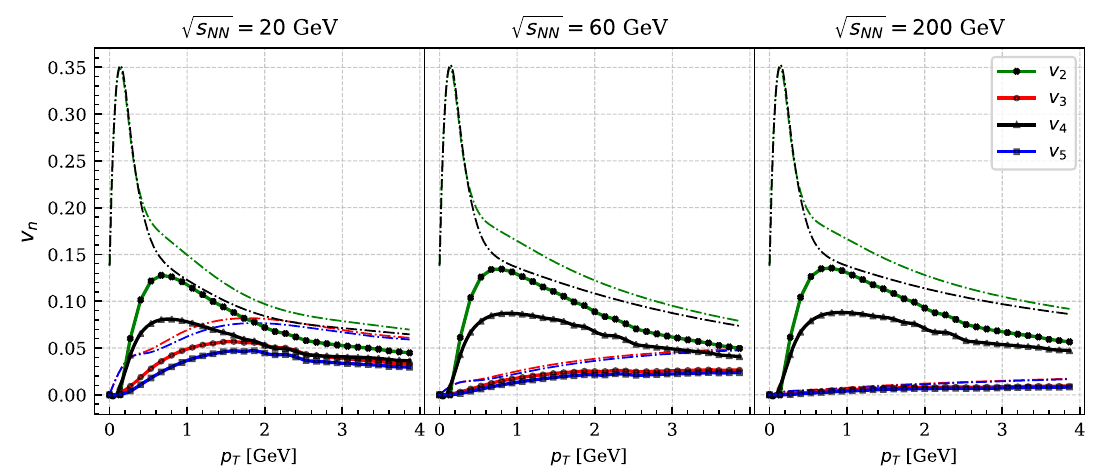
Fig. 4 Azimuthal harmonics computed using the prescription of Eq. (19). The parameters used for this plot are μ T = μ g = 0 . 4 GeV, μ = 0 . 2 GeV and η = η = 1 . 5. The dashed lines are the result P 1 2